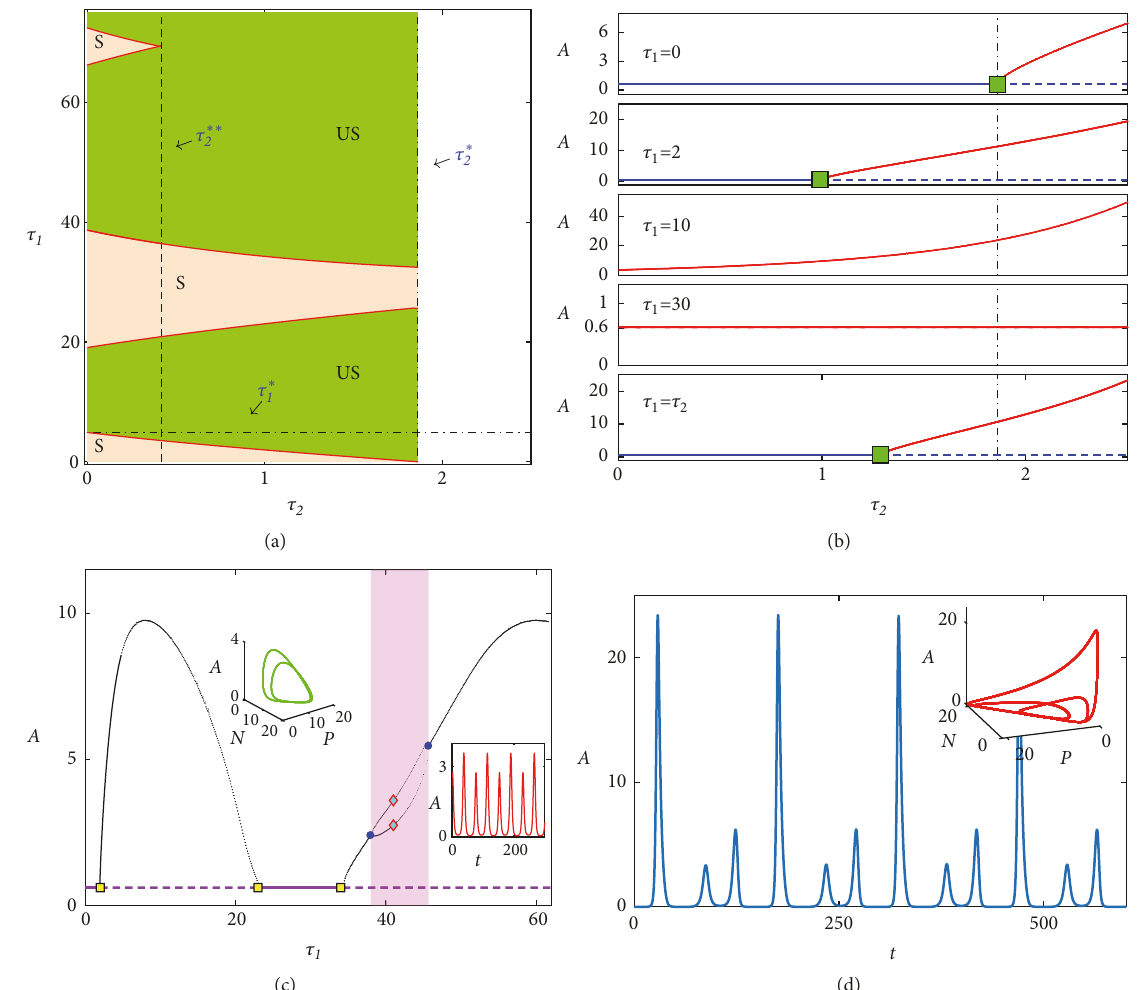
Figure 4: (a) Bifurcation diagram with 𝛽 2 = 0.7 for 𝜏 1 V.S. 𝜏 2 , where the symbol “S” denotes stable and the symbol “US” denotes unstable; (b) bifurcation diagram with 𝛽 2 = 0.7 for the effect of 𝜏 2 on nutrient-phytoplankton dynamics, where dashed line denotes unstable; solid line denotes stable; the green solid square is Hopf bifurcation point, dot-dashed line corresponding to 𝜏 ∗ 2 in (a), blue line represents equilibrium, and red line represents amplitude of periodic solutions. (c) Bifurcation diagram with 𝛽 2 = 0.7 and 𝜏 2 = 1 , where the yellow solid square is Hopf bifurcation point, the blue solid circleis bifurcation point for periodic-2solution, the magenta zone indicates the existenceof periodic-2 solutions, and the cyan solid diamond denotes the value of 𝜏 1 for a phase and a time-series in the inner of (c). (d) A periodic-3 solution for phytoplankton population, where 𝛽 2 = 0.7 , 𝜏 1 = 100 , and 𝜏 2 = 2